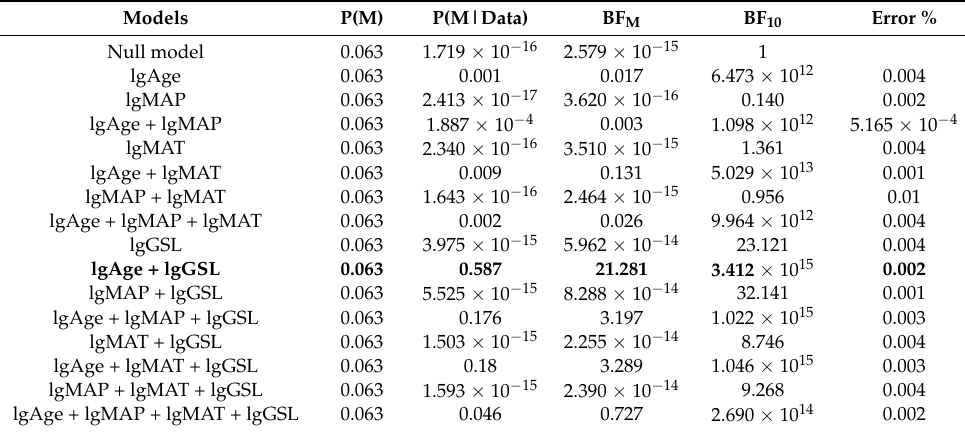
Table 2. Model comparison based on bayesian linear